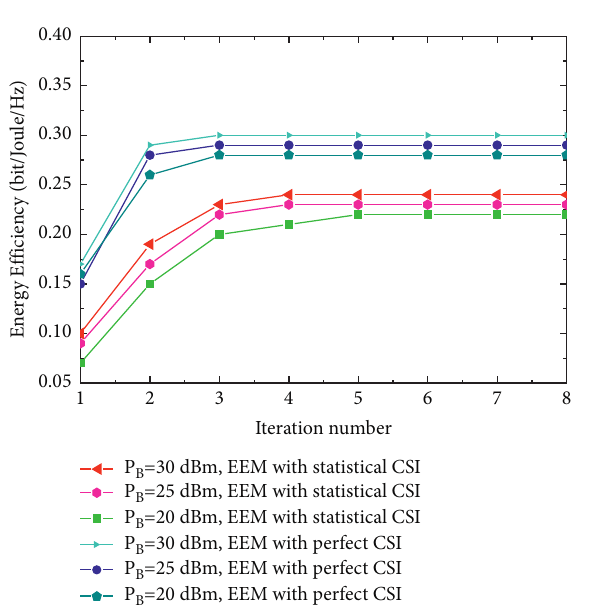
Figure 2: Convergence tendency of the energy efficiency in the two network scenarios.